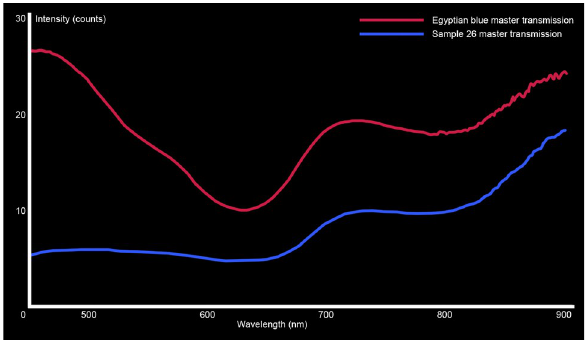
Figure 11. FORS spectrum of the area on the Hathor blue hairs of (SETI_26 blue line) compared with a reference